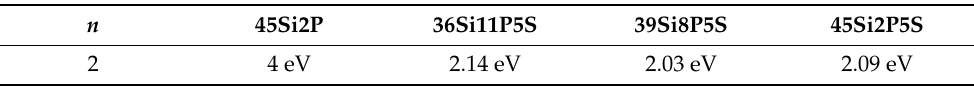
Table 4. The values of the band-gap energy for the glass samples 36Si11P5S, 39Si8P5S, 45Si2P5S, and 45Si2P in the case of indirectly allowed transitions; n =